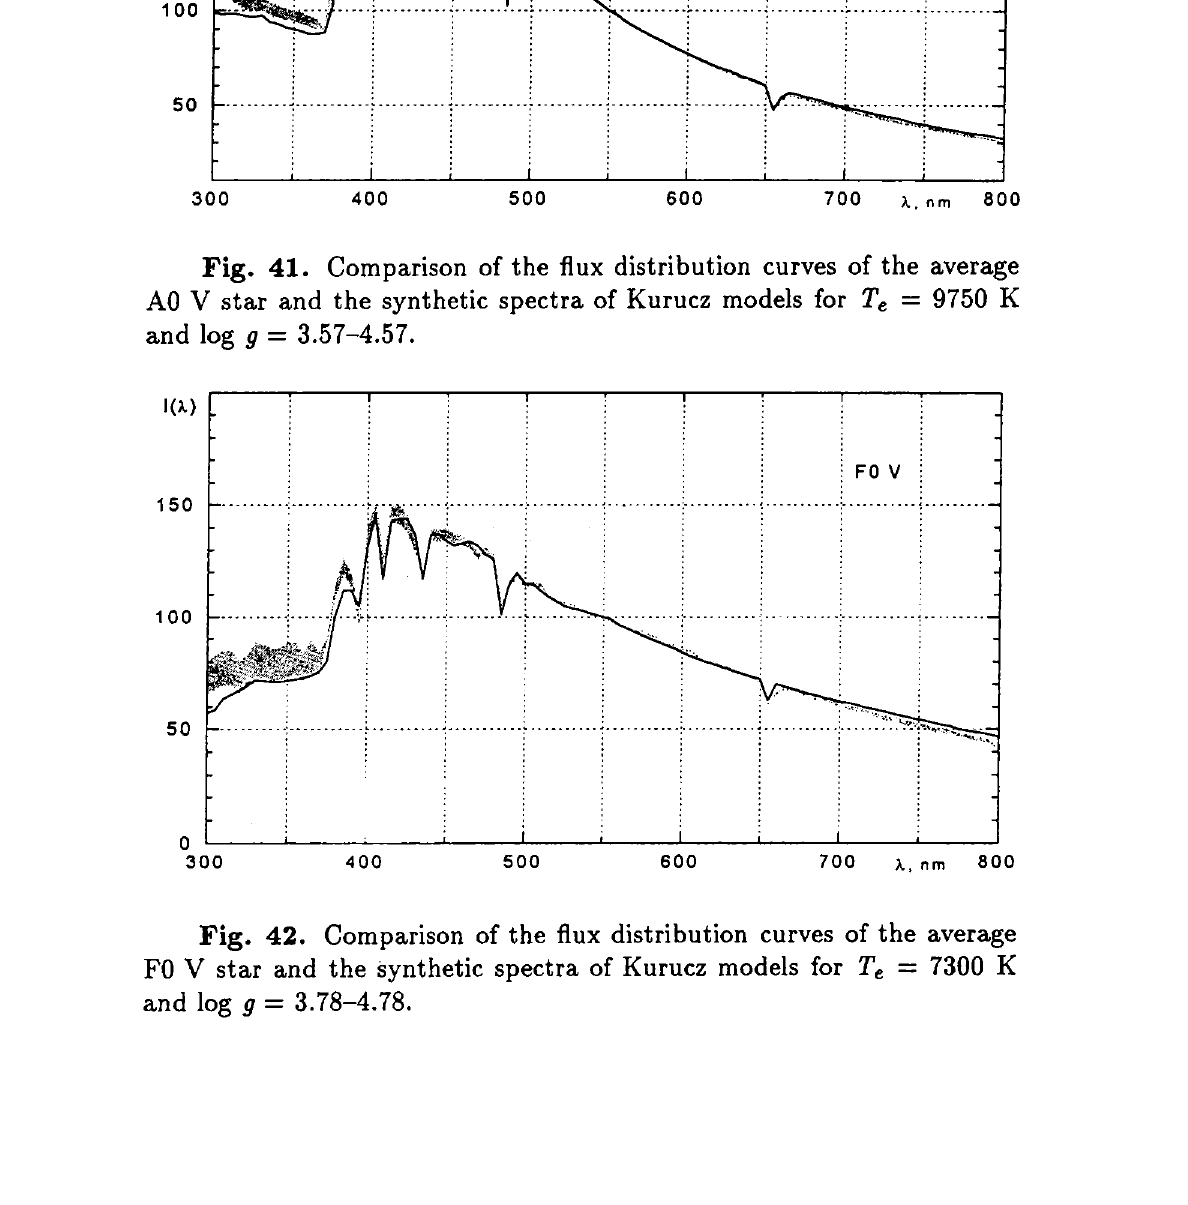
Fig. 42. Comparison of the flux distribution curves of the average F0 V star and the synthetic spectra of Kurucz models for T and log g =